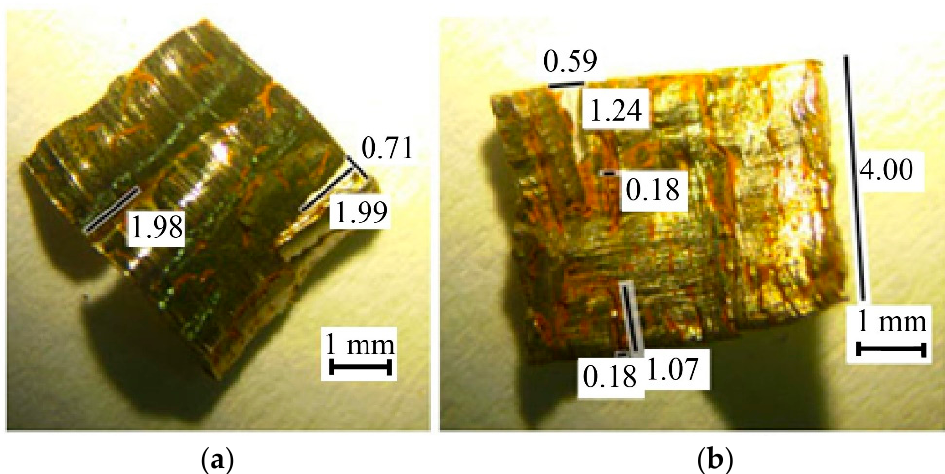
Figure 16. Chips formed during turning with water (demonstrating corrosion damage): outside ( a ); inside ( b ).